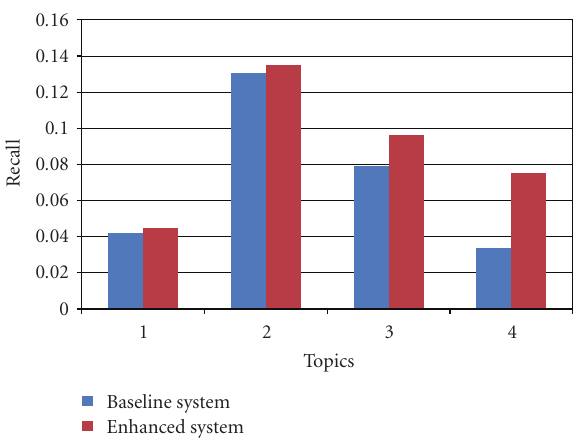
Figure 17: Recall for the results of the baseline and enhanced systems.